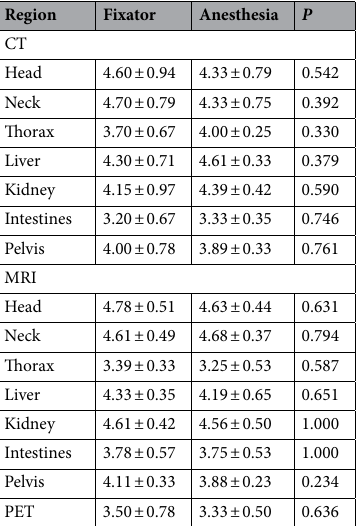
Region Fixator Anesthesia